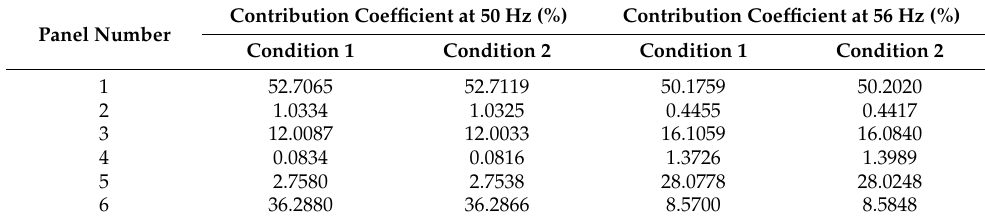
Table 6. The panel sound power level contribution coefficient.